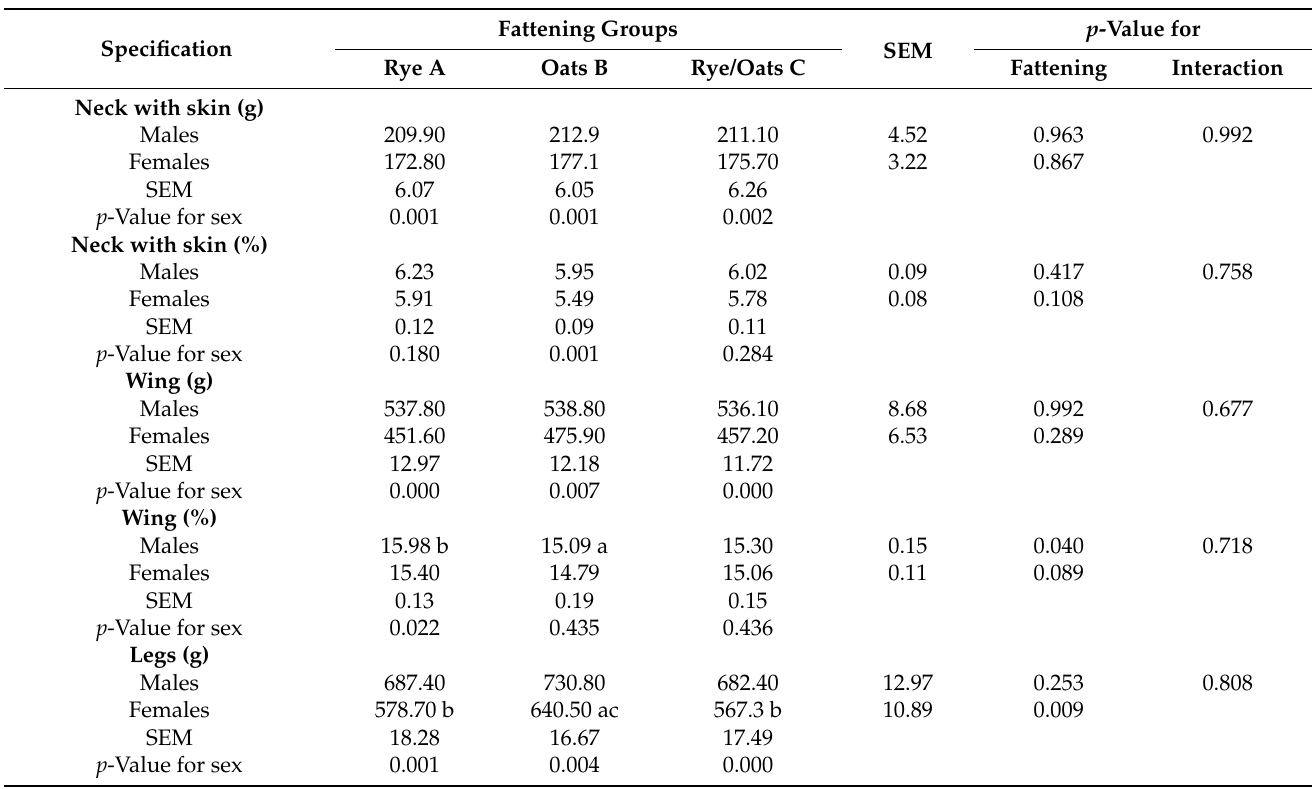
Table 4. Weight and the proportion of parts in geese